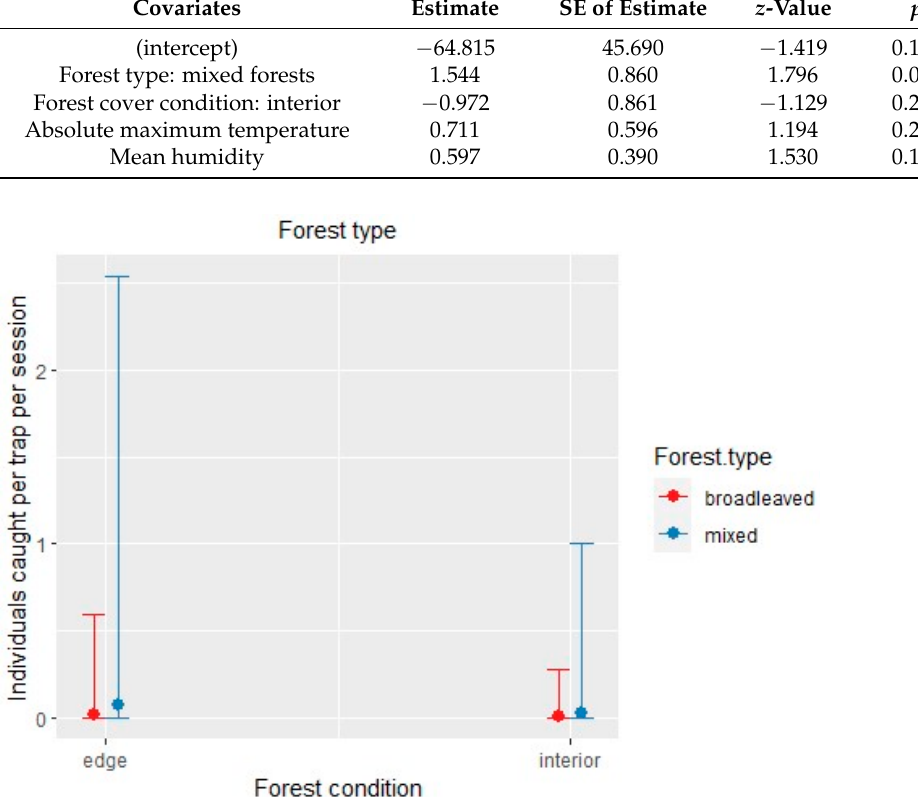
Figure 7. Xyleborinus saxesenii : effect of the negative binomial regression model’s covariates affecting the number of individuals caught by the trap triggered with alcohol per site and session. Only the conditional effect of habitat covariates (forest type: broadleaved vs. mixed; forest condition: edge vs. interior) is shown, as neither of the two meteorological variables showed significant effects.